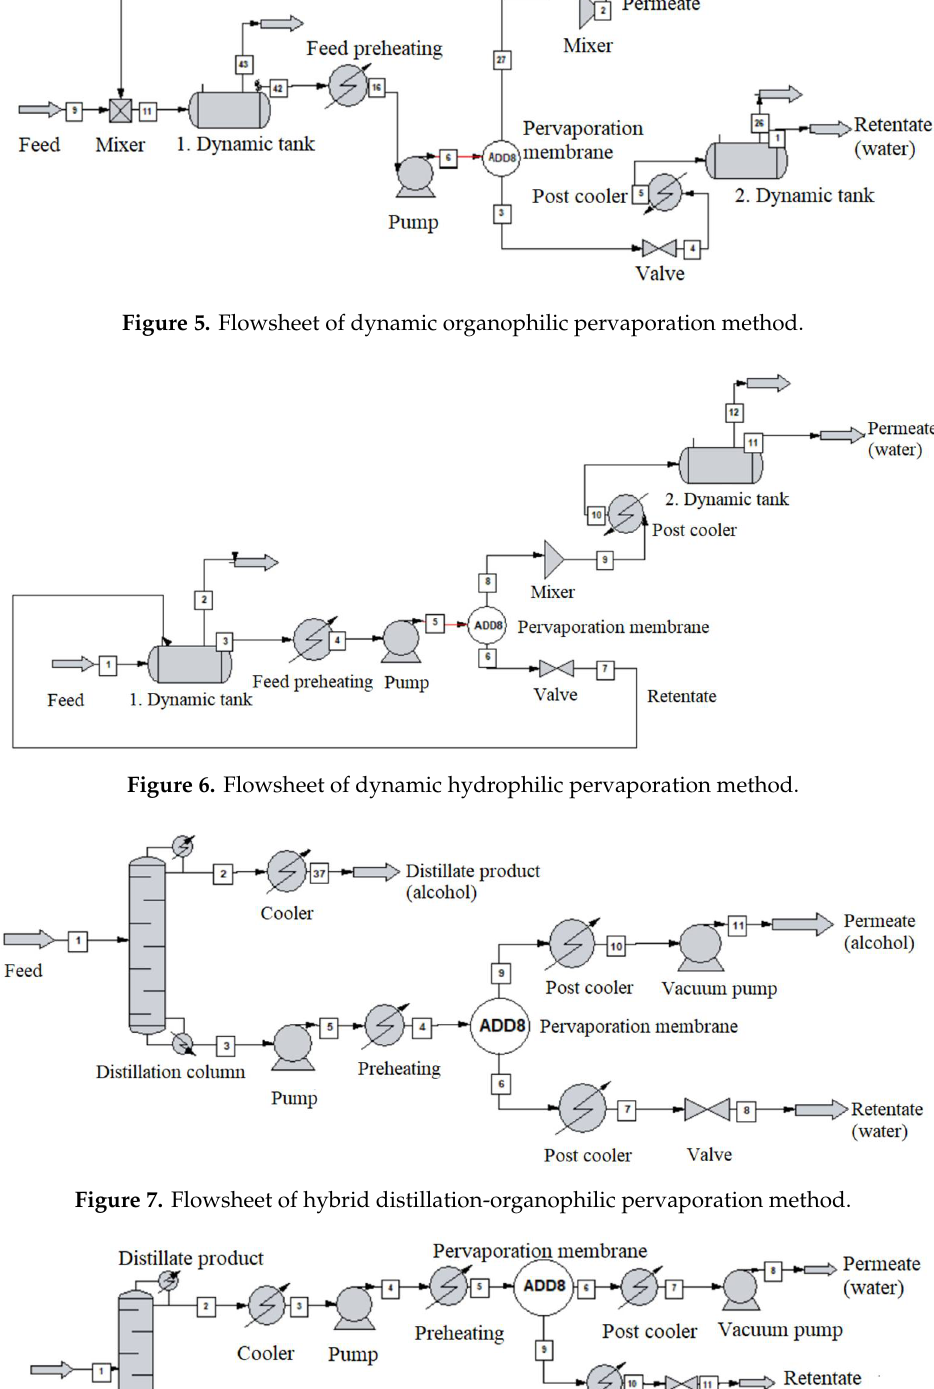
Figure 9. Flowsheet of the recirculation hybrid distillation-hydrophilic pervaporation method. 2.2. Membrane Characteristics, Feed Data In this paper, the properties of pervaporation membrane are adopted from the experiments performed by the Environmental and Process Engineering Research Group of BME, shown in Tables 1–4. Equation ( 1) shows the equation of developed Rautenbach model [73,74] on which the pervaporation calculation is based: J (cid:2919) = (1) Three different polymer membranes were experimentally examined for application of membrane flowsheet models. PERVAP™ 1210 (Table 2) and PERVAP™ 1510 (Table 4) are hydrophilic pervaporation membranes to separate ethanol-water or methanol-water mixtures. PERVAP™ 4060 (Tables 3 and 5) is an organophilic pervaporation membrane used to separate the alcohol-water mixtures. The experimental results have published in [72,74–76]. Tables 2–5 summarize the optimized parameters of experimental investigations. These parameters were used to build up the semi-empirical model (see Equation (1)) in the ChemCAD flowsheet program. The other major